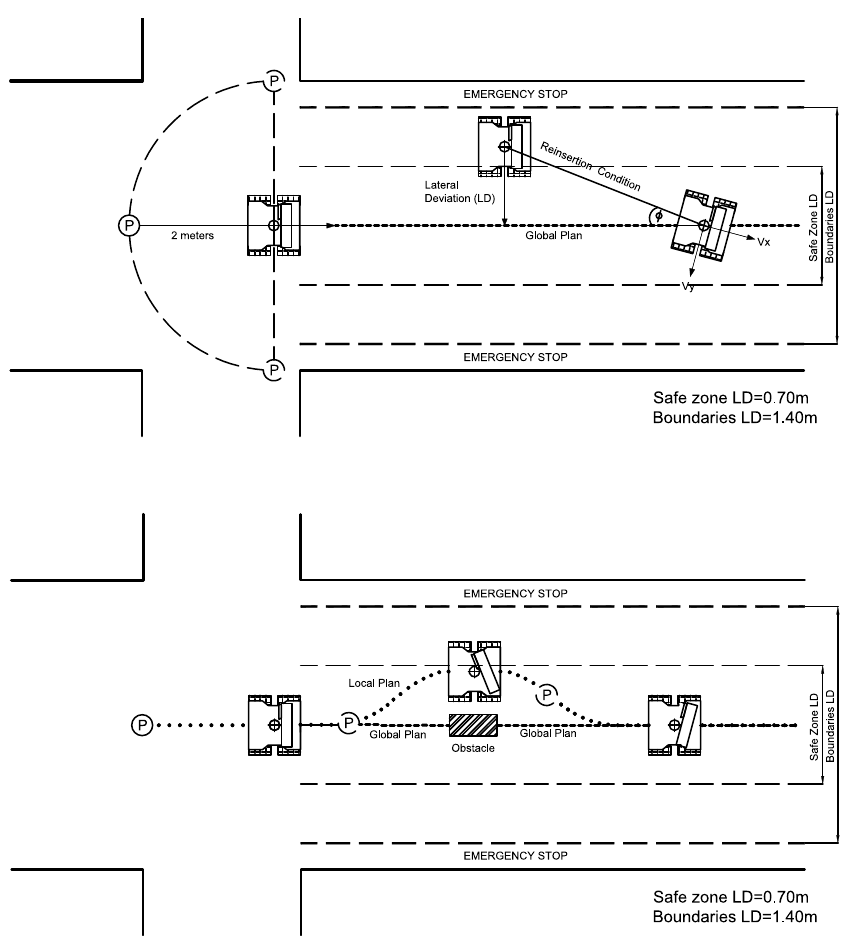
Figure 4. Schematic diagram of the operation of the lane-keeping